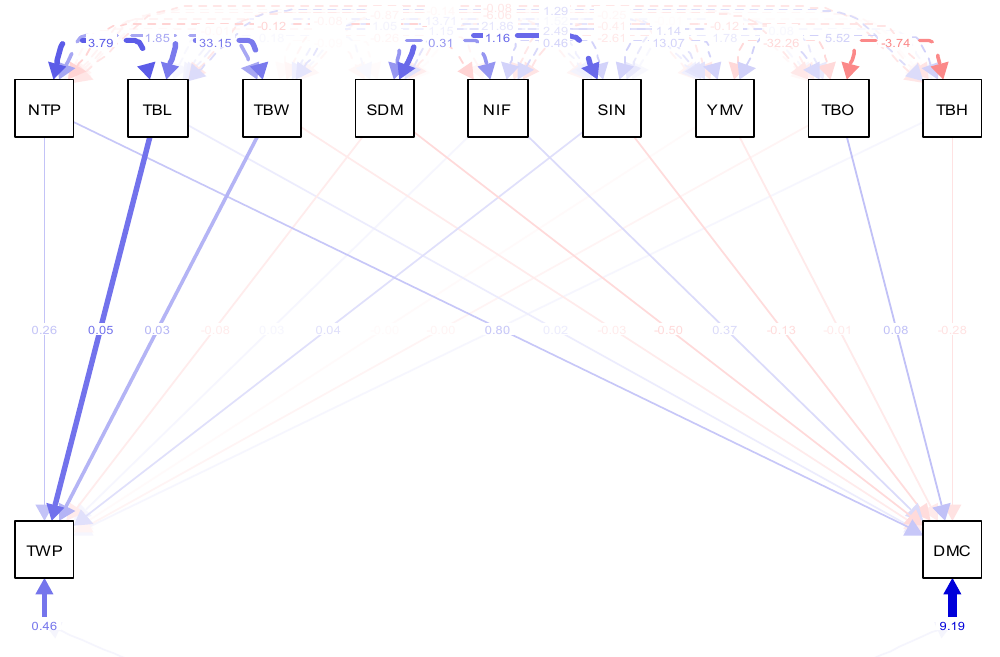
Figure 3. Path coefficient analysis among evaluated 11 quantitative traits using tuber weight per plant and dry matter contents as dependent variables. TWPL: tuber weight per plant; NTP: number of tubers per plant; TBL: tuber length; TBW: tuber width; SDMP: stem diameter per plant; NIFB: number of